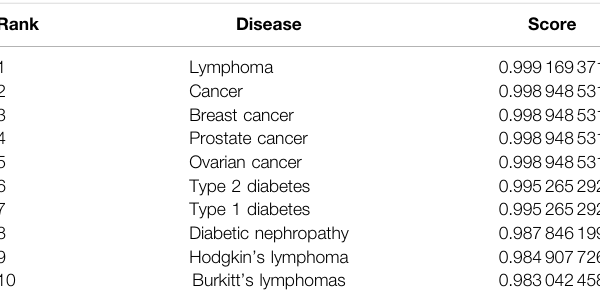
TABLE 6 | The top 10 predicted diseases related to “ PVT1.